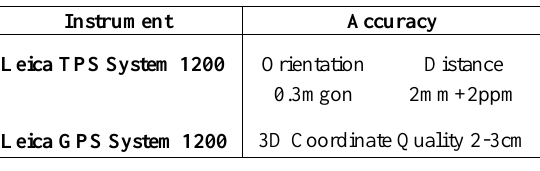
Table 2. Camera specifications, Panasonic Lumix